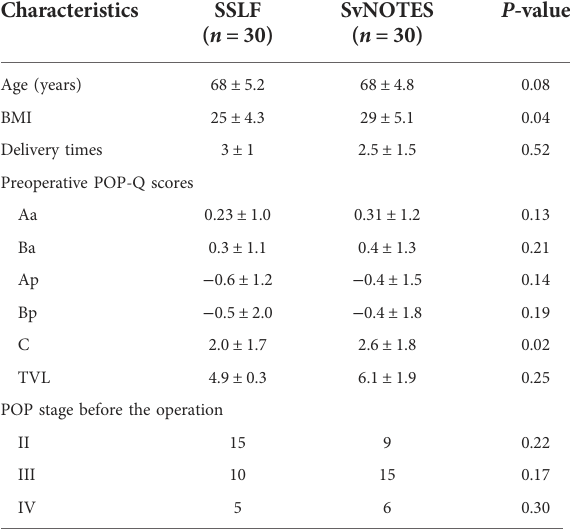
TABLE 1 Characteristics of the study patients ( n =101). a